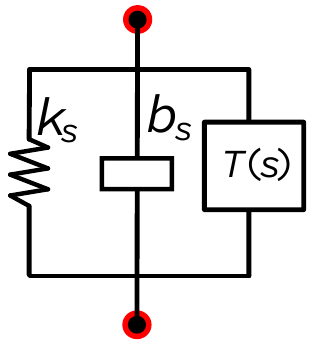
Figure 3. General layout of the seat suspension .